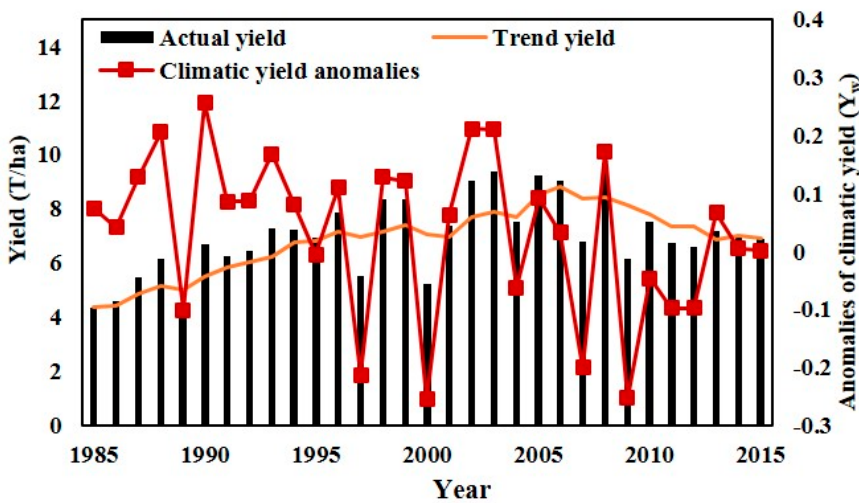
Figure 2. Interannual variations of actual yield, trend yield, and climatic yield anomalies for maize in Midwestern Jilin Province.